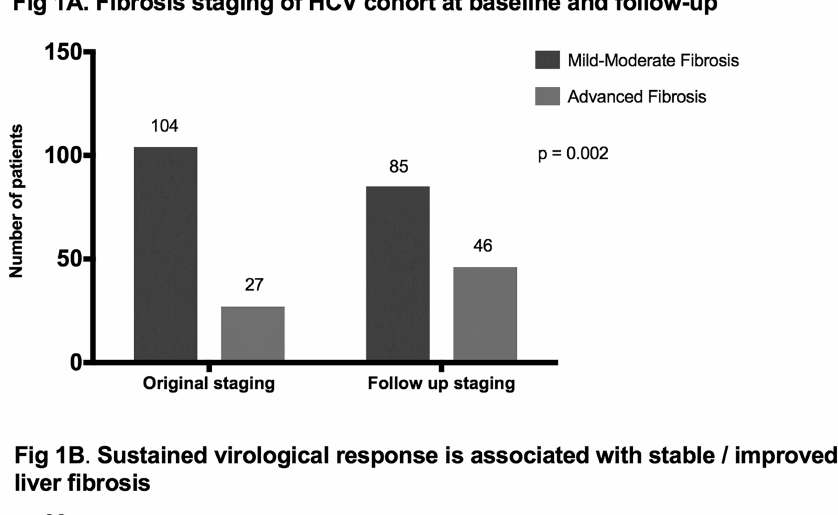
fibrosis at baseline. On univariable analysis, predictors of liver fibrosis progression among those